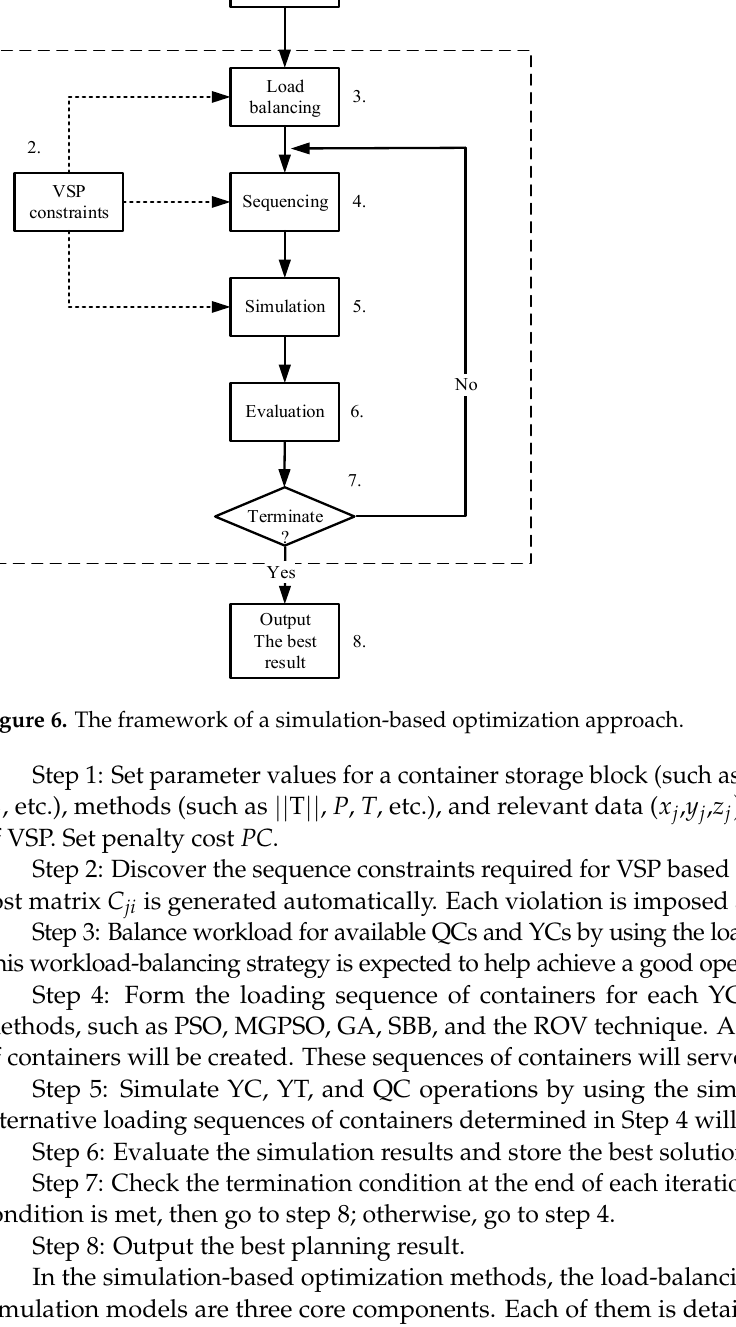
Algorithm 1 The Logic of Workload Balance for Equipment (QCs or YCs)